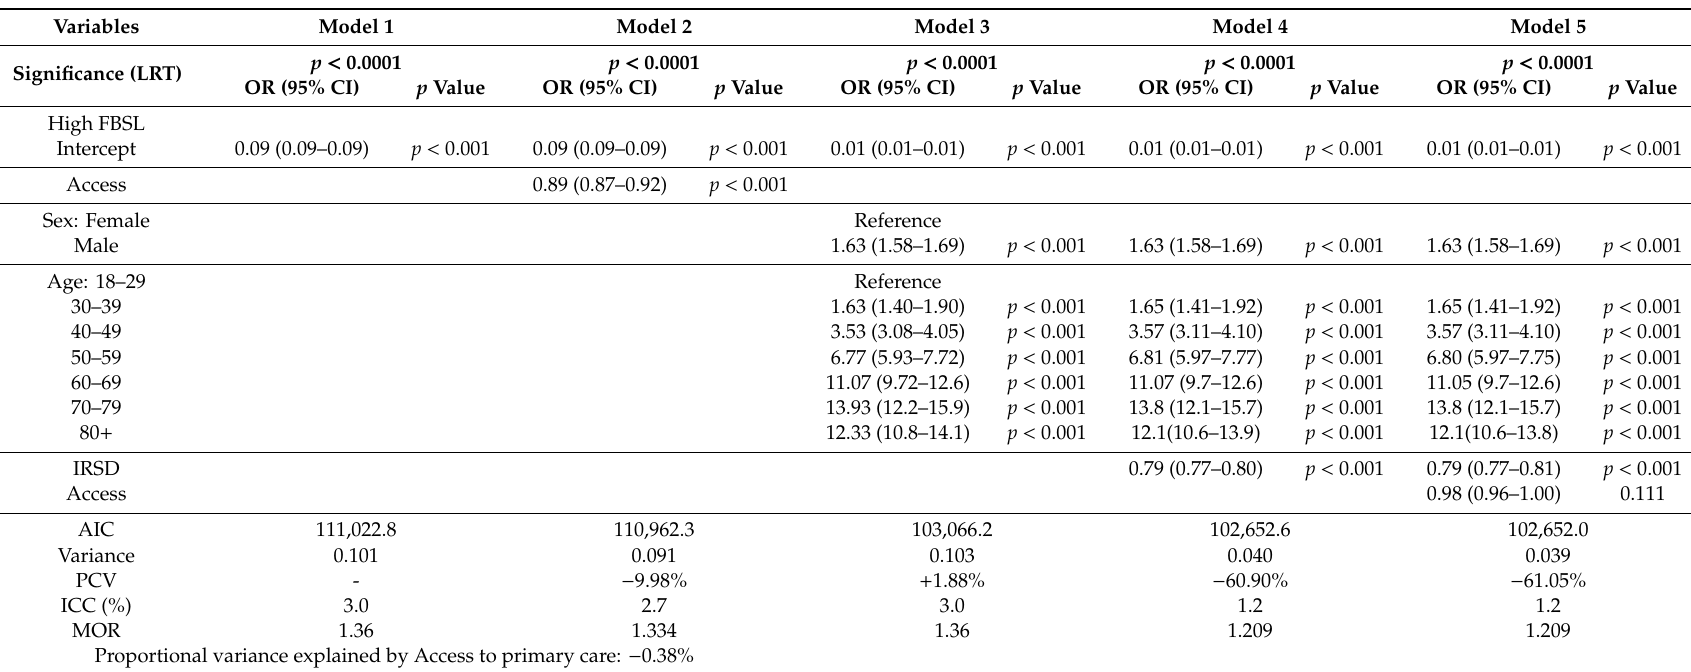
Table 3. Multilevel logistic regression model summaries of high FBSL (FBSL ≥ 7.0 mmol /